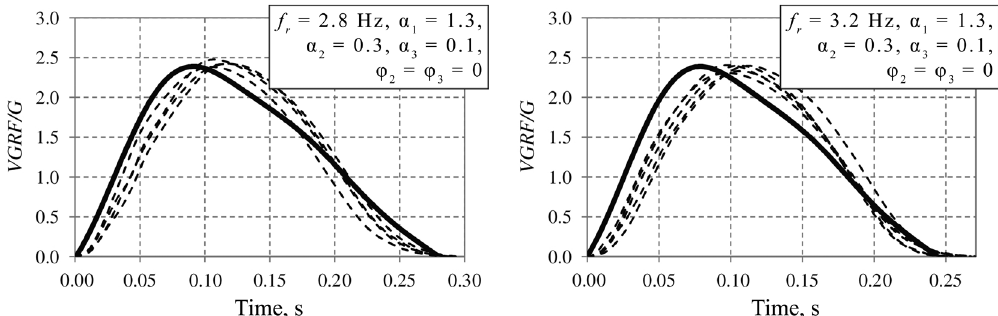
Figure 7. The normalised VGRF / G determined for f r = 2.8 Hz and f r = 3.2 Hz using Eq. (1) for input parameters recommended in Rainer & Pernica (1986) and Rainer et al. (1988) (input parameters presented in the